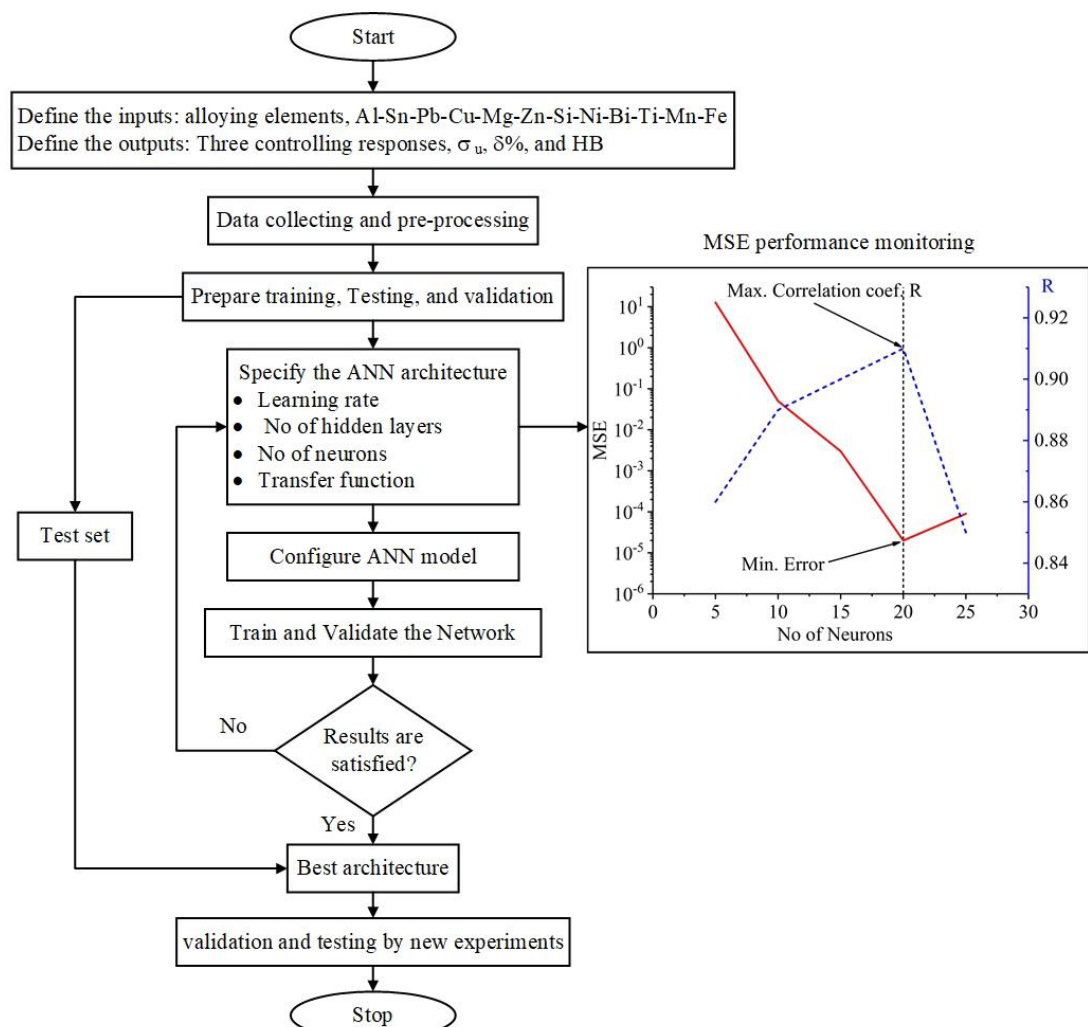
Figure 7. Flow chart of the constructed model and the impact of neurons on the MSE and correlation coefficient. Table 6. The R, RMSE, and AARE (%) of experimental and predicted stress for different numbers of hidden layers. One Hidden